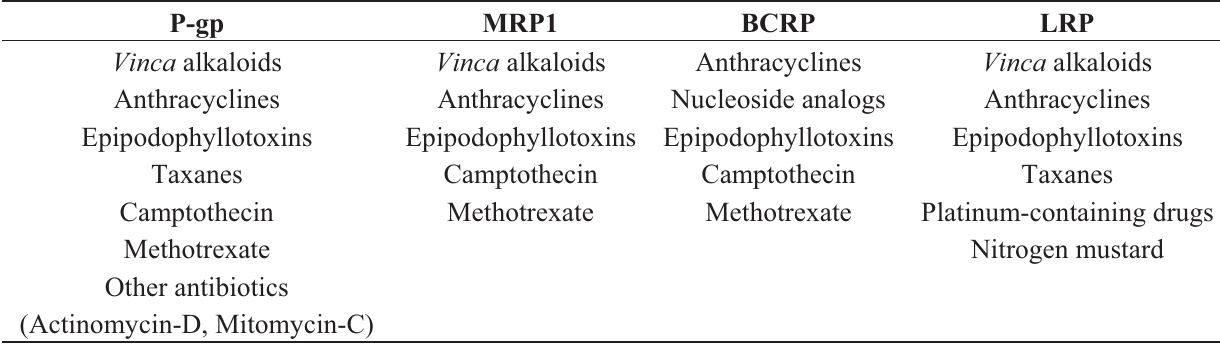
Table 1. Representative conventional chemotherapeutic agents that are substrates of drug